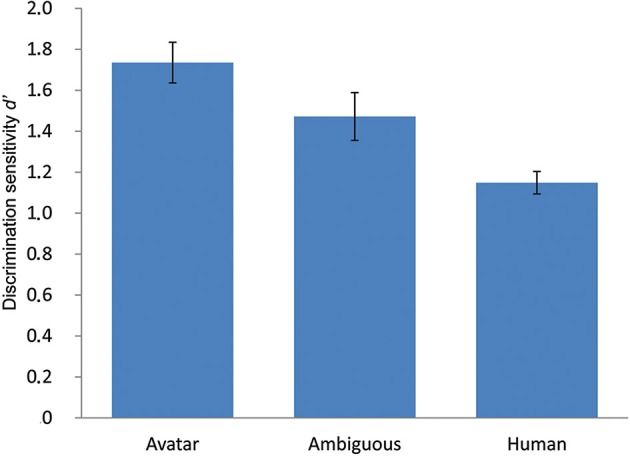
Results of the ABX perceptual discrimination task. The figure depicts mean discrimination sensitivity d′ in the ABX perceptual discrimination task for unambiguous avatar and human and highly ambiguous faces. The profile of d′ shows a marked asymmetry along the continua, meaning that unambiguous avatar (and the ambiguous faces) are perceived as more dissimilar than equally spaced human faces. Contrary to the implicit assumption in the UVH, perceptual discrimination difficulty is greatest for human faces. The error bars indicate 1 SE (N = 49).